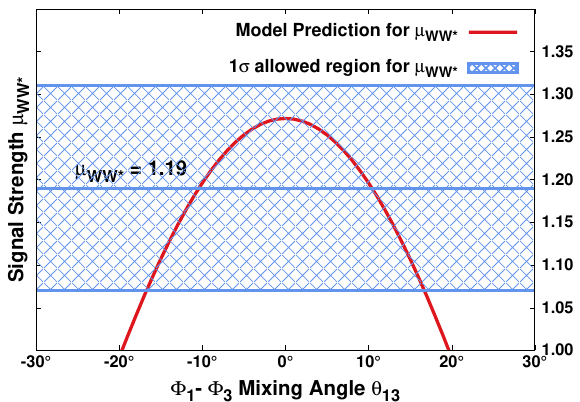
Figure 1. Variation of µ with the CP-even mixing angle θ 13 is shown with the dashed red WW? line. The allowed shaded one sigma region for measured µ = 1 . 19 ± 0 . 12 [59] is also WW?